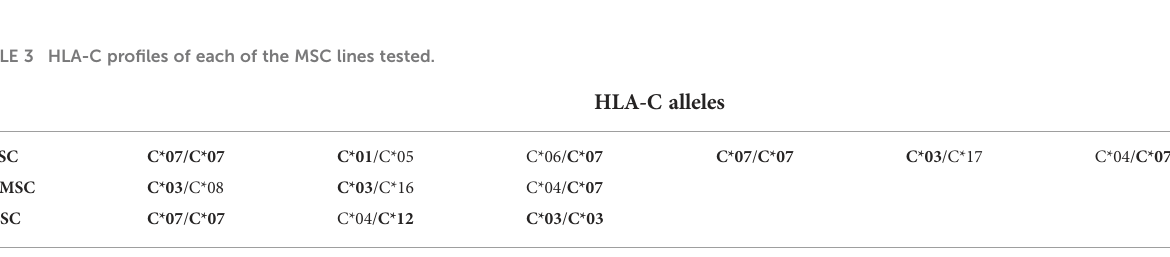
TABLE 3 HLA-C pro fi les of each of the MSC lines tested.